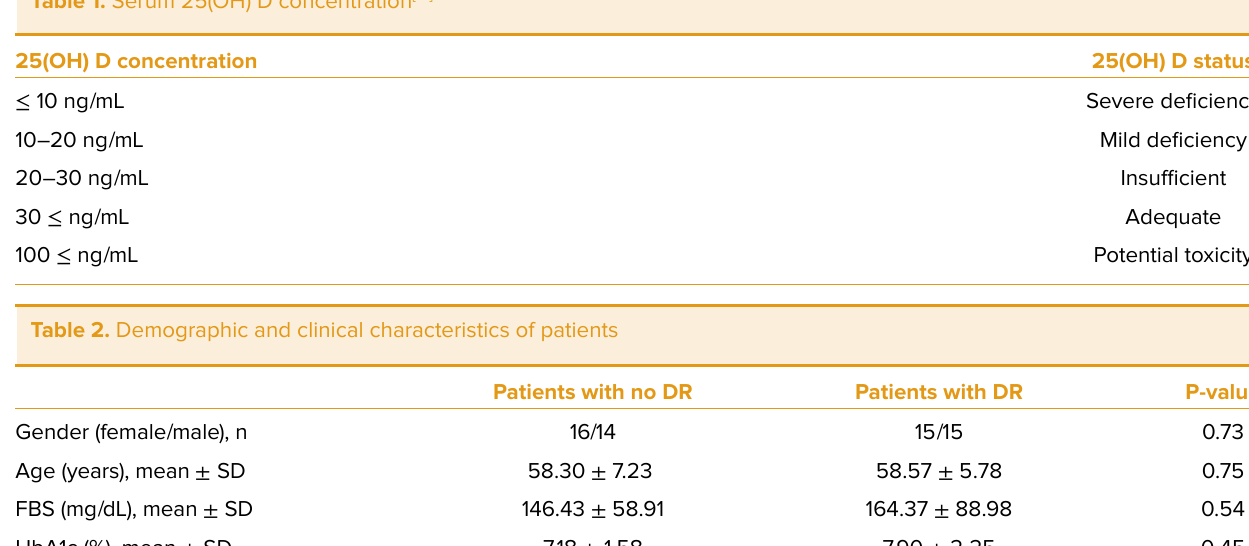
Table 1. Serum 25(OH) D concentration [14]